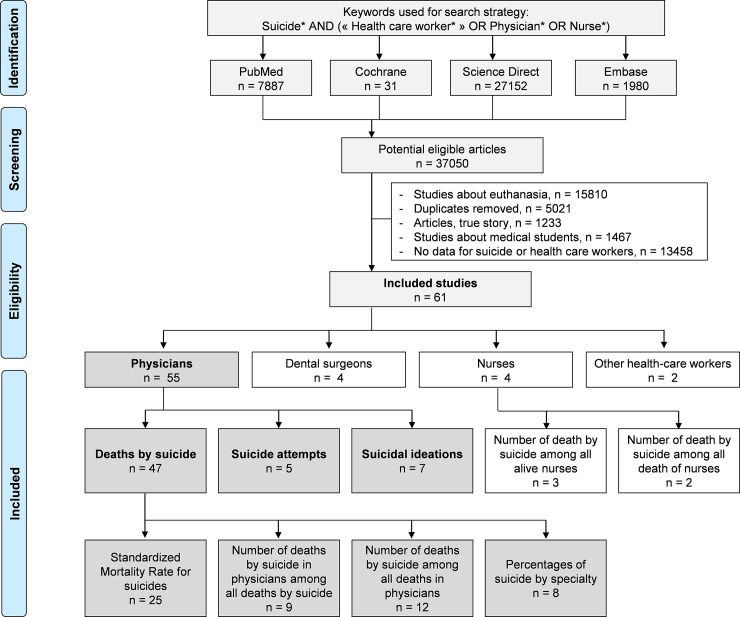
Search strategy.